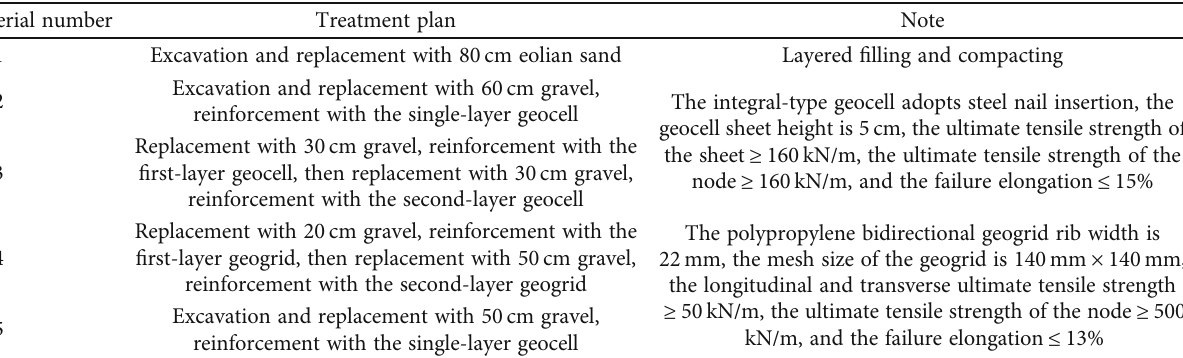
Figure 2: Schematic diagram of soft soil sampling. Table 2: Experimental section of the subgrade base treatment plan.